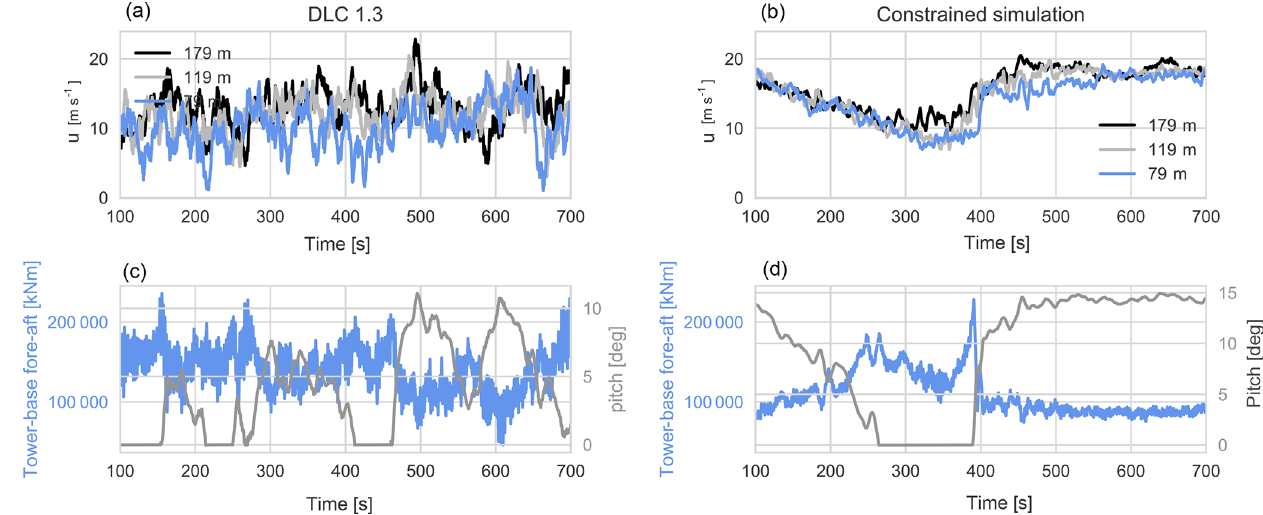
Figure 10. Comparison of a DLC 1.3 time series (a, c) and a constrained simulation time series of an extreme event (b, d) . (a, b) The u component wind speed. (c, d) Tower-base fore–aft moment (blue) and pitch angle (grey).